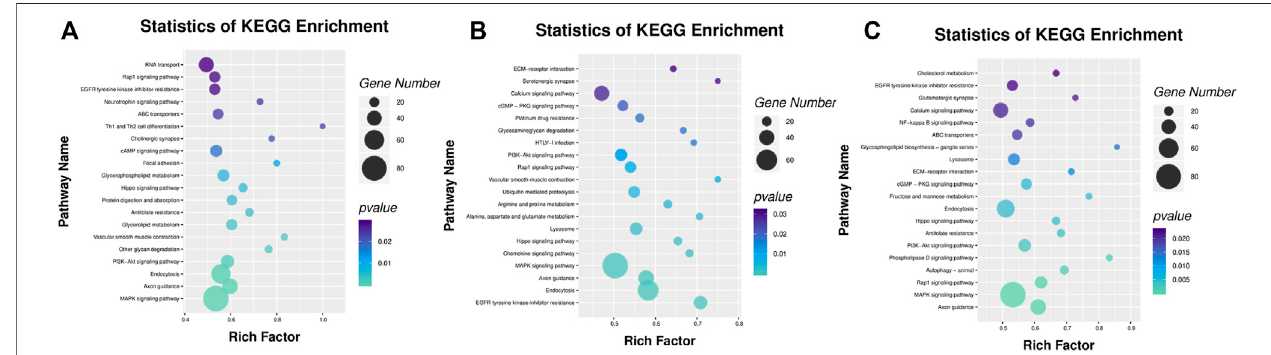
FIGURE 8 | Hub pathways and associated genes in piglets of the IS vs. IR group suffering from C. perfringens type C infection.